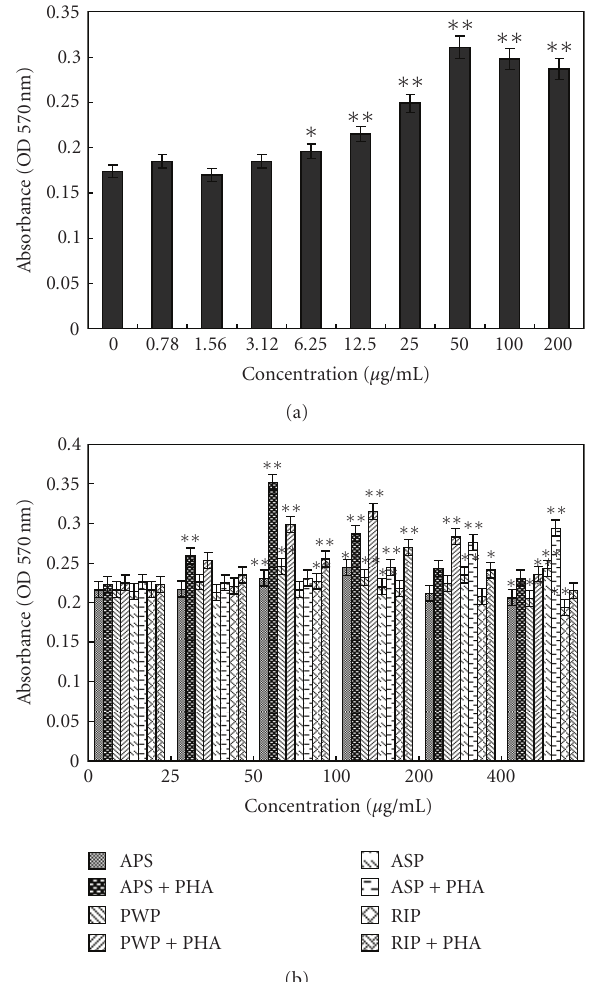
Figure 4: (a) E ff ect of red kidney bean lectin on multiplication of mouse splenic lymphocytes (OD 570 va1ue). (b) Influence of CHPs applied separately, and concurrent application of CHPs with 12.5 μ g/mL red kidney bean lectin, on multiplication of mouse splenic lymphocytes (OD 570 va1ue). CHP: Chinese herbal polysaccharide; APS: Astragalus mongholicus polysaccharide; PWP: Poria cocos polysaccharide; ASP: Angelica sinensis polysaccharide; IRP: indigowoad root polysaccharide. Data represent means ± SD ( n = 3). Data were analyzed by one-way analysis of variance. ∗ P < . 05, ∗∗ P < . 01, compared with CHP applied